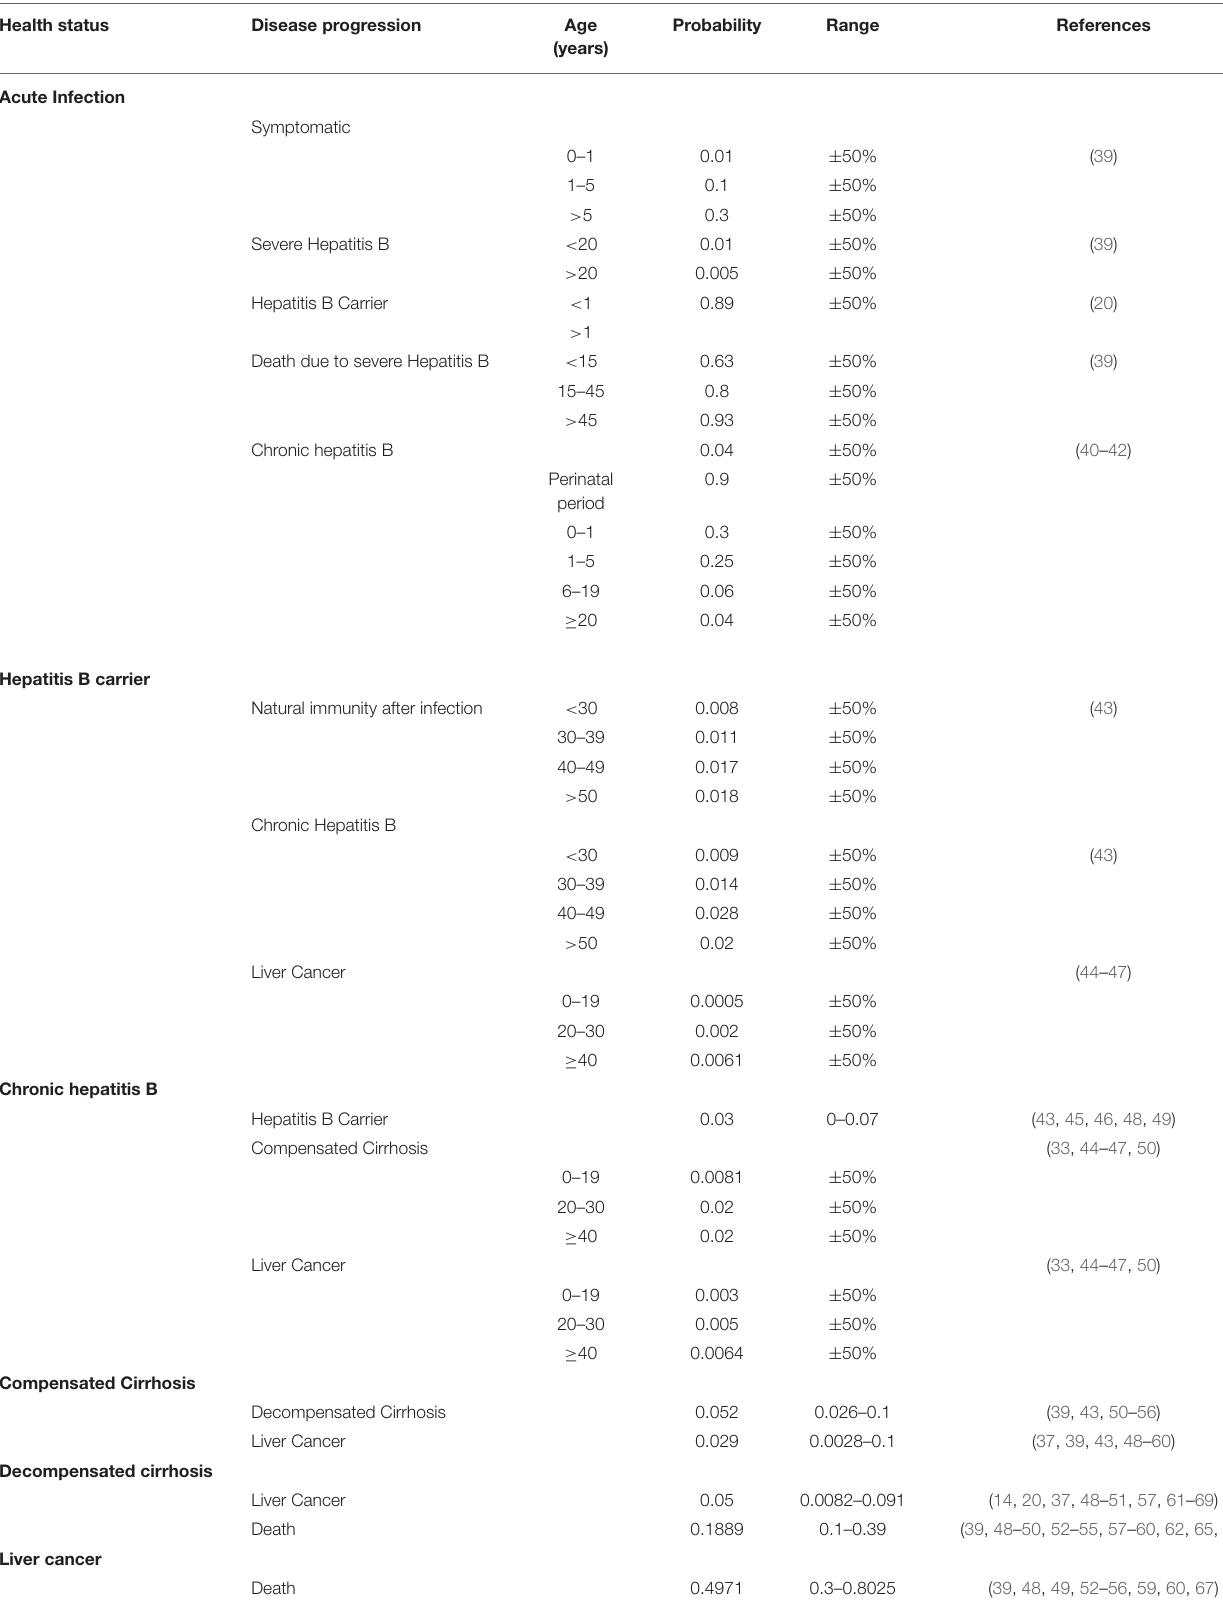
TABLE 3 | Status and probability of disease transition after HBV